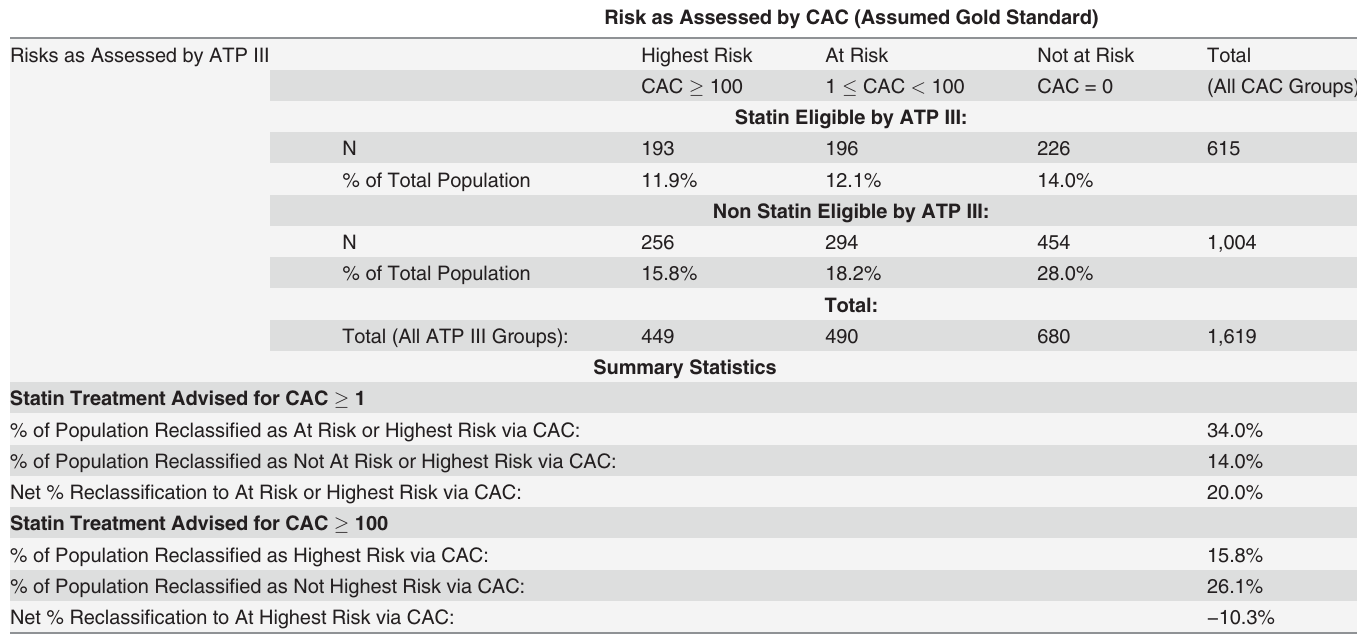
Table 2. Re-Classi fi cation of ATP III Assessed Statin Eligibility by CAC.